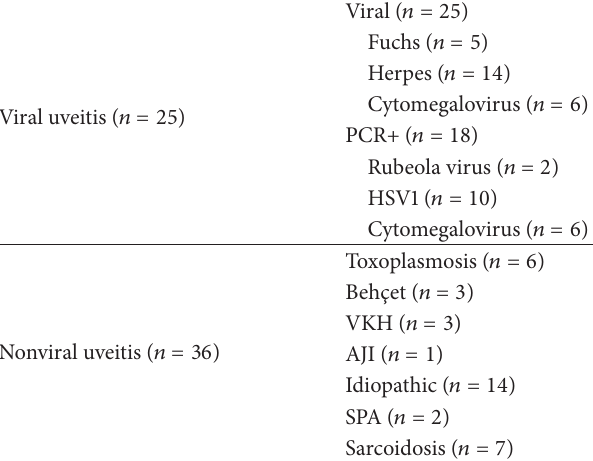
Table 1: Etiologies of